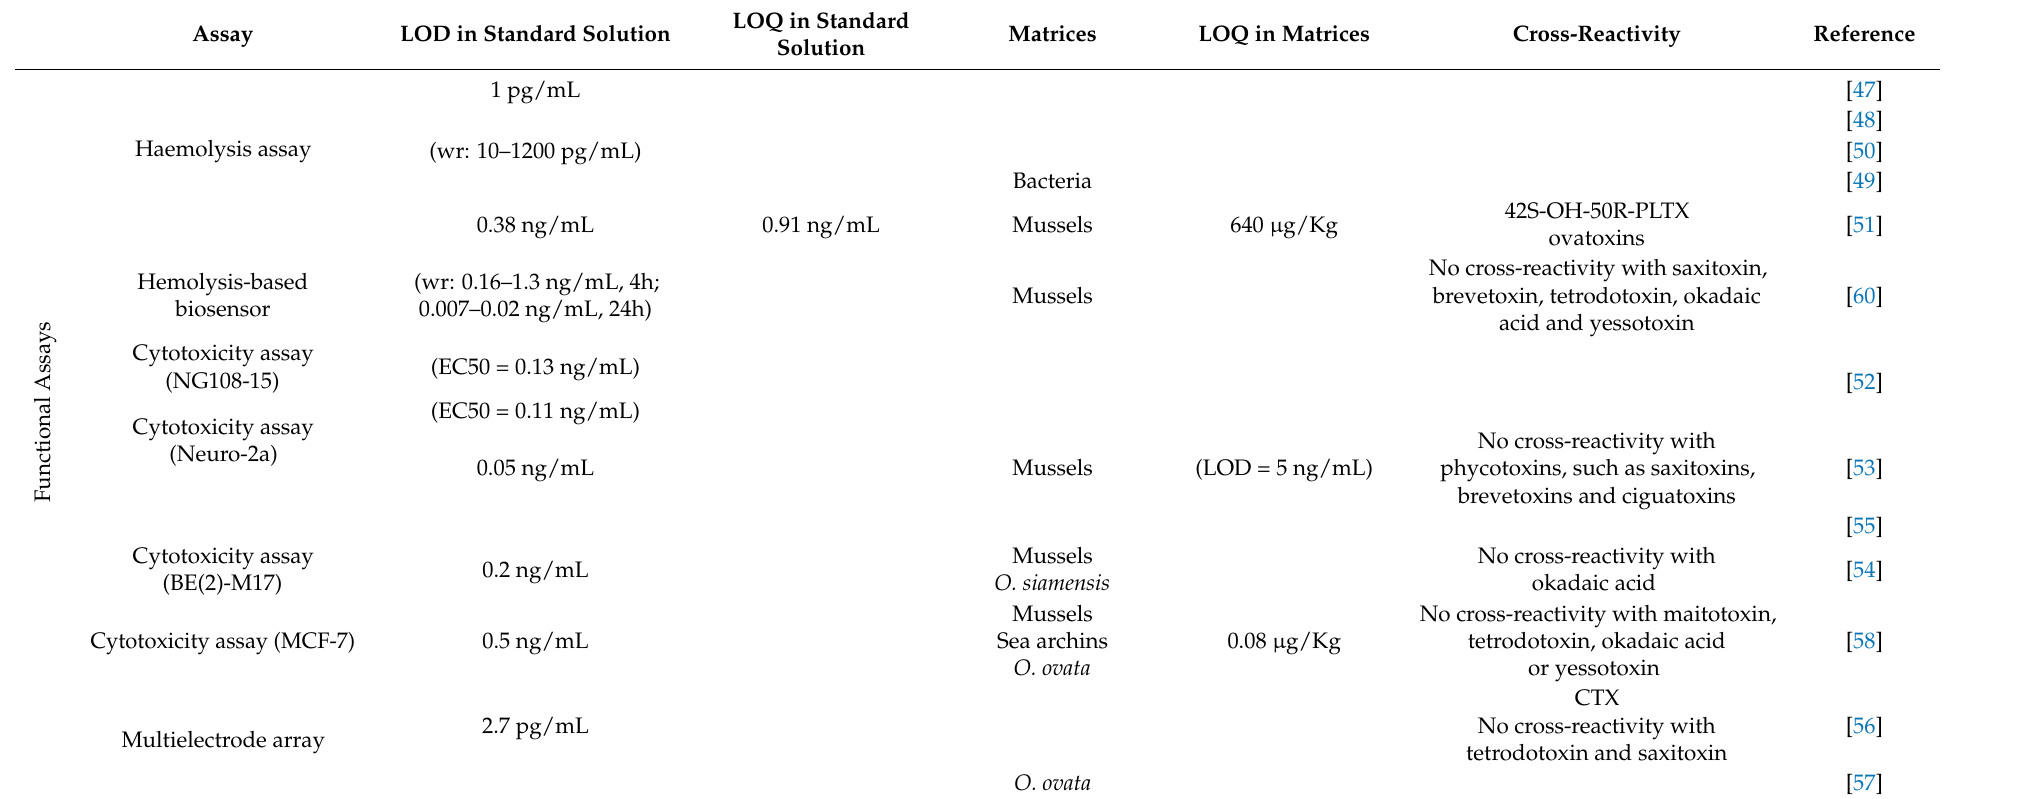
Table 1. Functional assays for PLTX